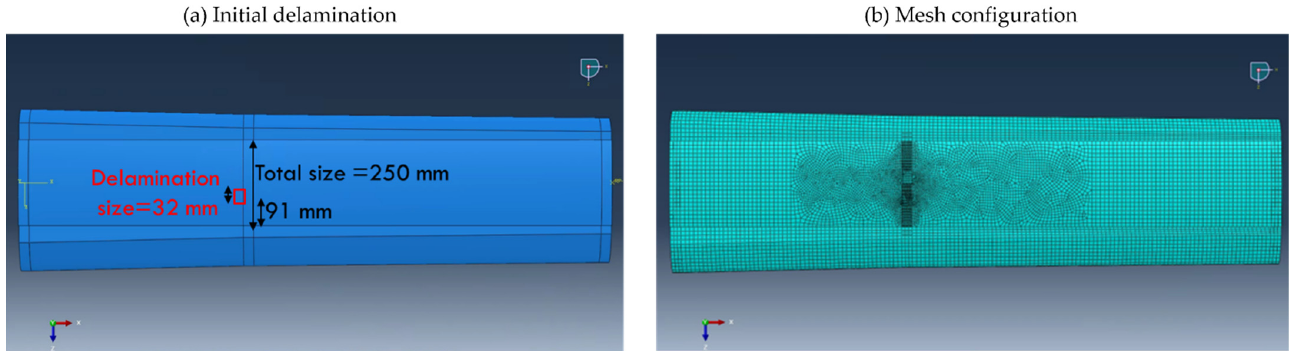
Figure 5. Skin-debonding damage in aircraft tail wing structure.